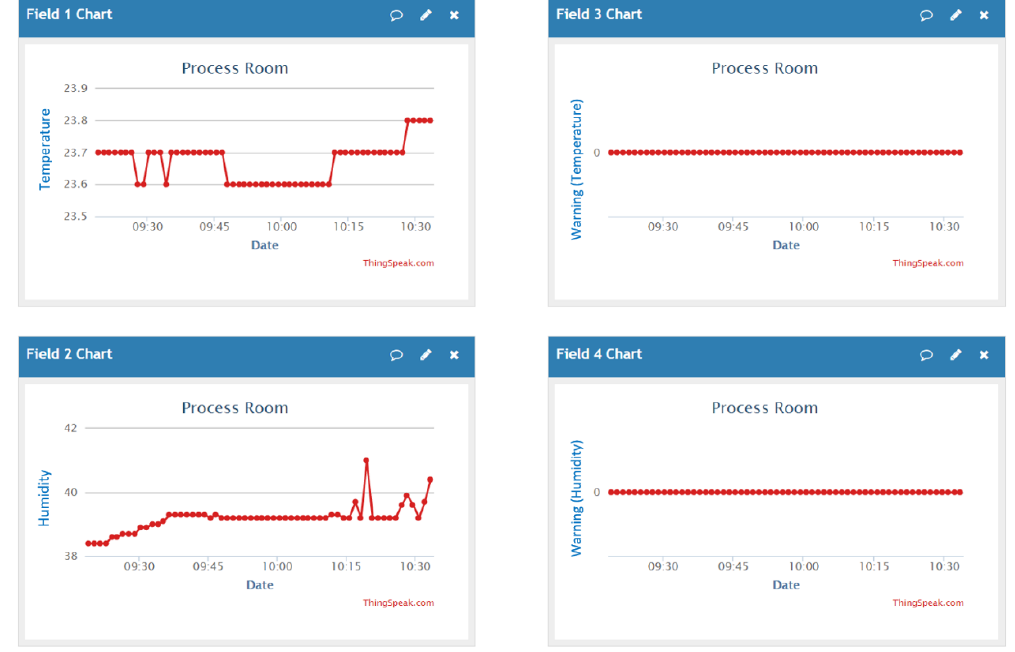
Figure 9. Temperature and humidity curves and alarm curves recorded on the ThingSpeak website.